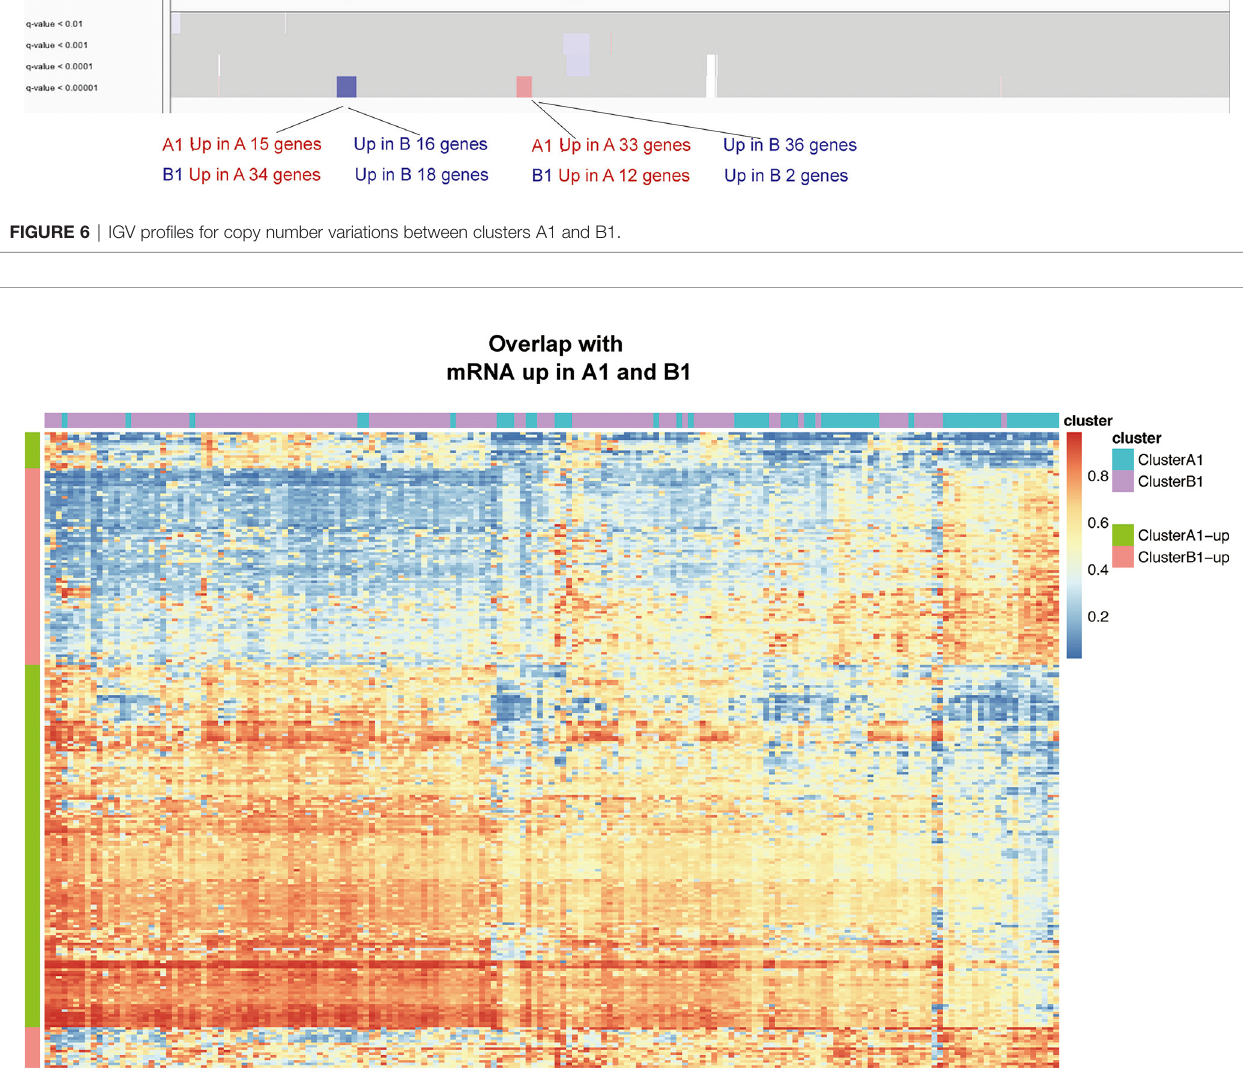
FIGURE 7 | Heat map showing intersection of differential DNA methylation and DEGs between clusters A1 and